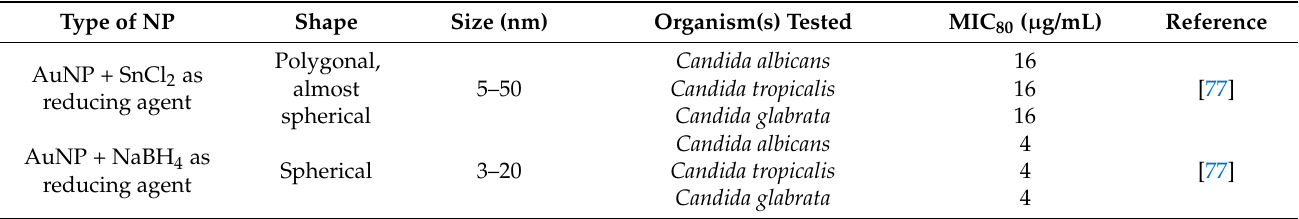
Table 3. Activities of NPs tested on different fungal species expressed as MIC 80 ( µ